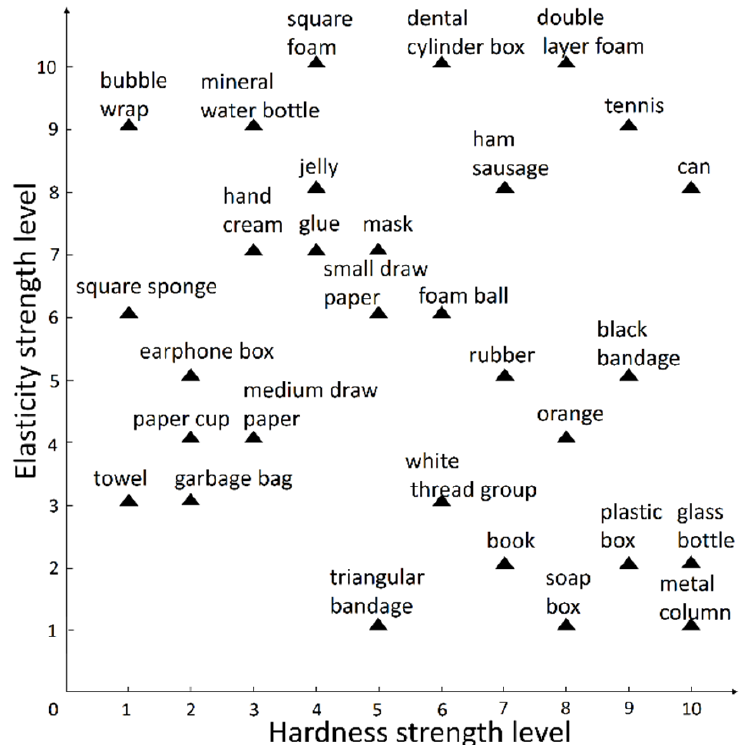
Figure 4. Horizontal graph of the elasticity and hardness strength level of 30 objects in the NumaTac haptic data set.